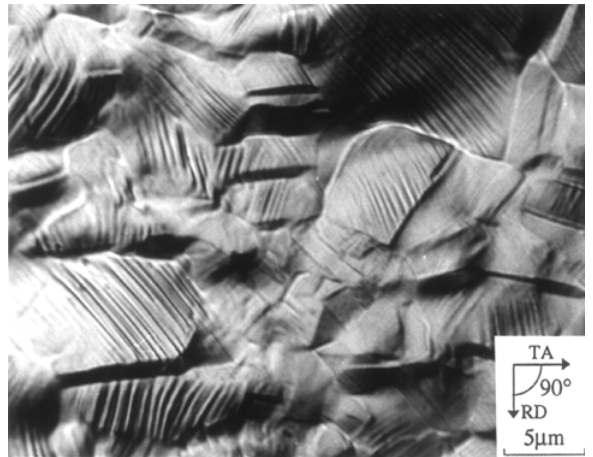
Figure 7. Optical observation of slip lines, developed during the second deformation in the macroscopic localized region (after rupture). The prestrain value is equal to